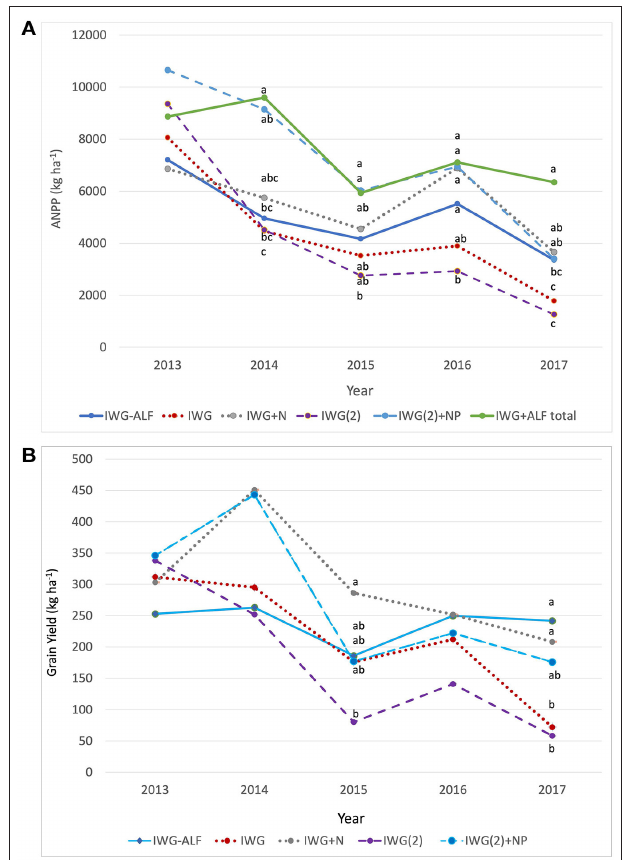
FIGURE 2 | Productivity of IWG as influenced by crop density, diversity, and fertility treatments. (A) Aboveground net primary productivity (ANPP) of IWG (kg ha − 1 ) in monoculture and biculture treatments as well as ANPP of IWG-ALF including alfalfa (IWG + ALF total–green line) for all years, and (B) Grain yields of IWG (kg ha − 1 ) in monoculture and biculture treatments for all years. Different lowercase letters represent significant differences within years ( P < 0.05) based on Tukey pairwise